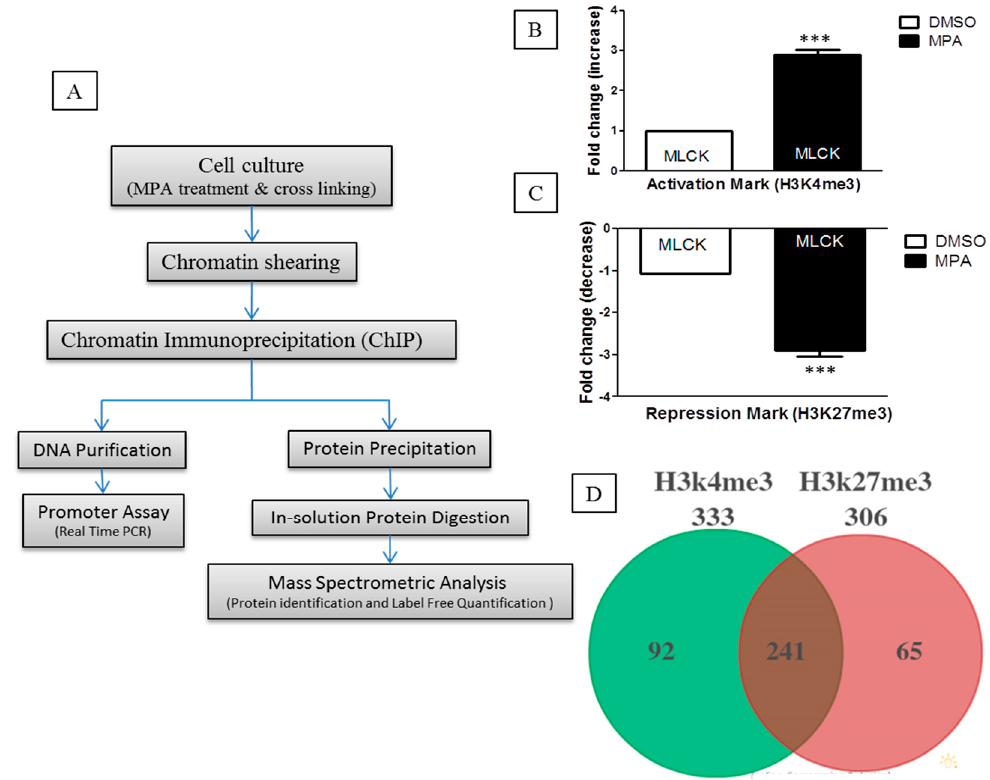
Figure 1. Cont. Figure 1.